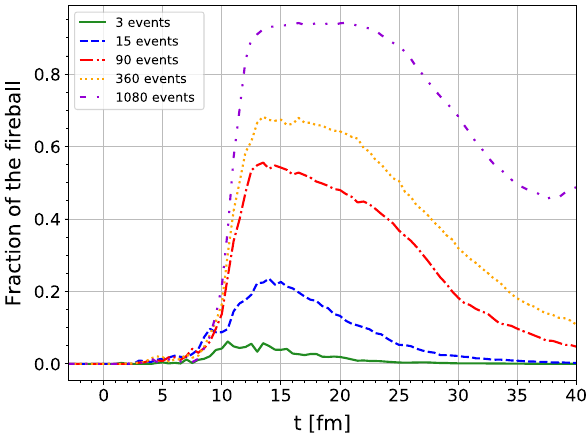
Fig. 15 Time evolution of the average fraction of the system satisfying theconditions X < 0 . 3, Y < 0 . 3, ε > 1MeV / fm 3 forAu+Aucollisions at E lab = 1.23 AGeV, 0–5%, 5–20% and 20–50% centrality classes